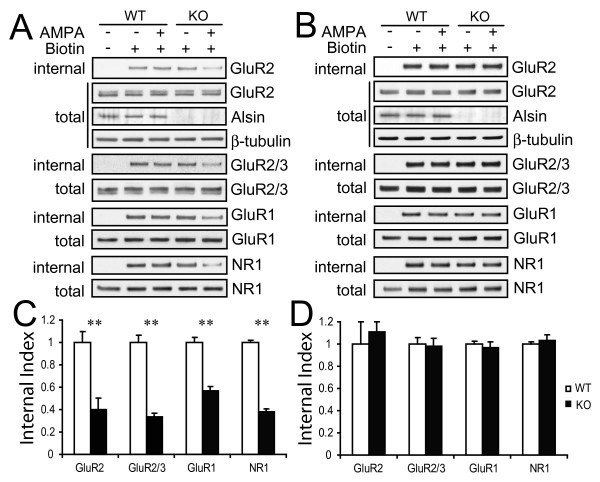
Increased degradation of glutamate receptors in ALS2-/- neurons following AMPA treatment. A. The biotinylated internalized cell surface proteins were affinity purified and immunoblotted with antibodies against glutamate receptors: GluR1, GluR2, GluR2/3, and NR1 (labeled as "internalized"). The neurons were treated with mock (AMPA-) or AMPA (AMPA+) prior to the biotinylation. The expression of each glutamate receptor and β-tubulin in total cell lysate (labeled as "total") was also blotted to normalize the accumulation of internalized proteins. B. Similar to A, except that neurons were pre-incubated with lysosome inhibitor leupeptin. C. Histogram reveals a significant decrease of internalized glutamate receptors in KO neurons as compared with WT controls (n > 6). Error bars represent SEM. ** P < 0.01. D. Histogram shows that in the presence of leupeptin, no significant alteration of internalized glutamate receptors was observed between WT and KO neurons (n > 6). Error bars represent SEM.